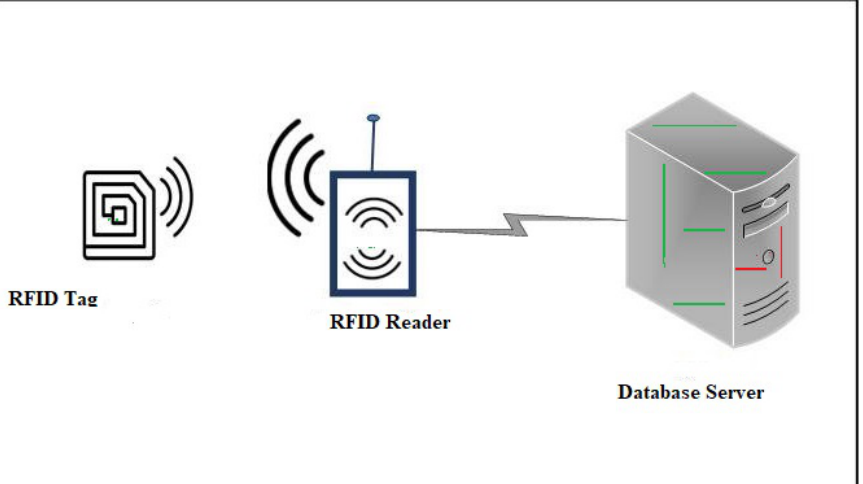
Figure 1. Architecture of the